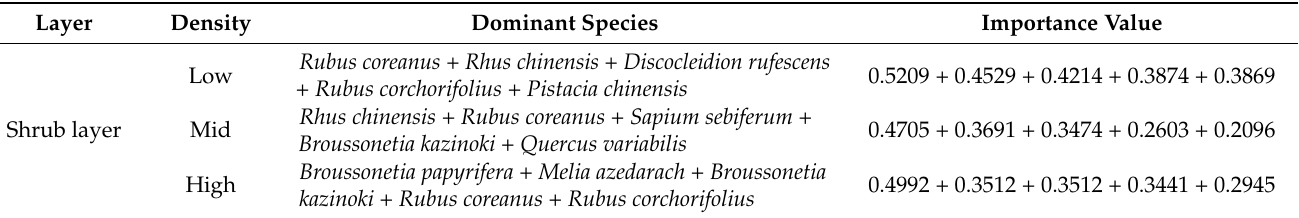
Figure 2. Species composition of the understory plants in Pinus massoniana plantations with different stand densities. Table 2. Important values of the understory vegetation dominant species in Pinus massoniana with different